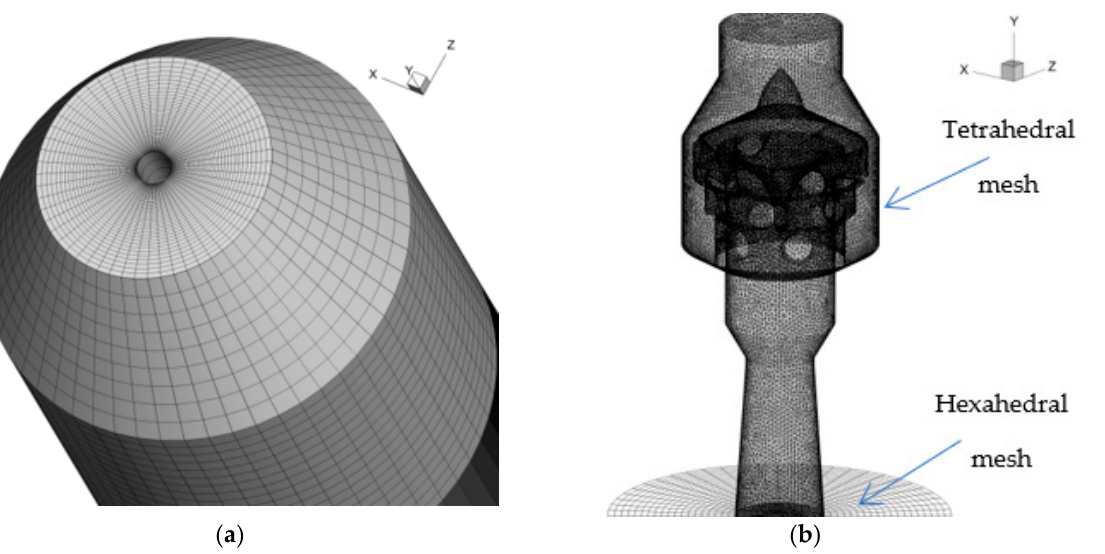
Figure 4. Mesh and structure of converter and cyclone nozzle: ( a ) mesh of converter; ( b ) mesh of cyclone nozzle.